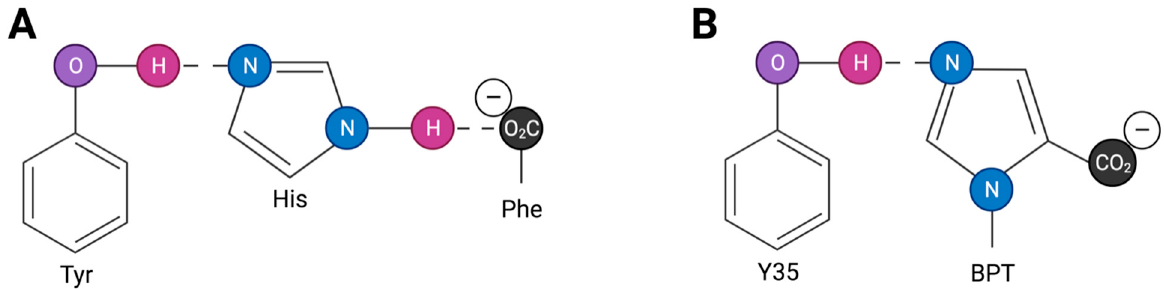
Figure 5. ( A ) Intra CRS in Ang II; ( B ) inter CRS in the complex AT1R/ARB